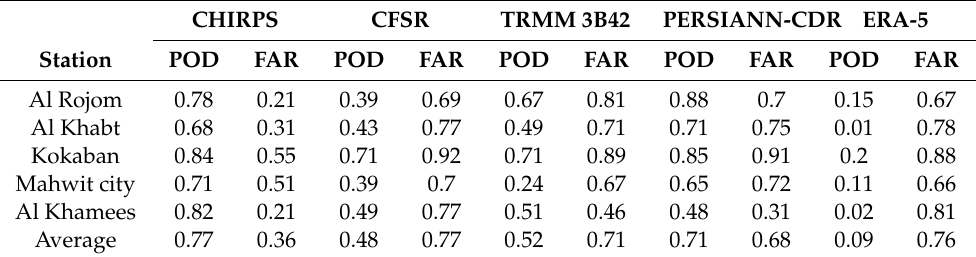
Table 5. Summary of categorical statistics of the Al Mahwit